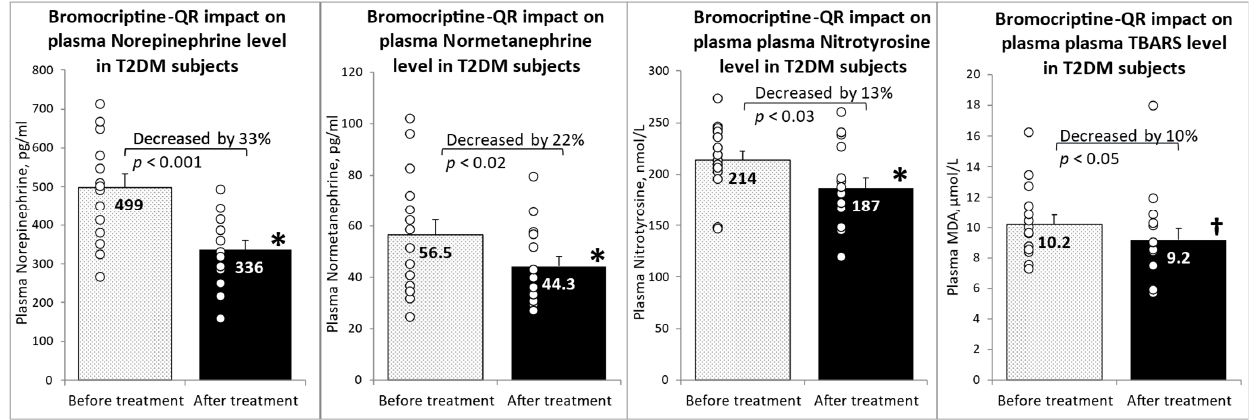
Figure 1. Effect (change from baseline) of 4 months of bromocriptine-QR treatment on plasma markers of elevated sympathetic tone and oxidative stress. * Significant, 2-tailed t -test; † Signi fi cant, 1-tailed t -test.